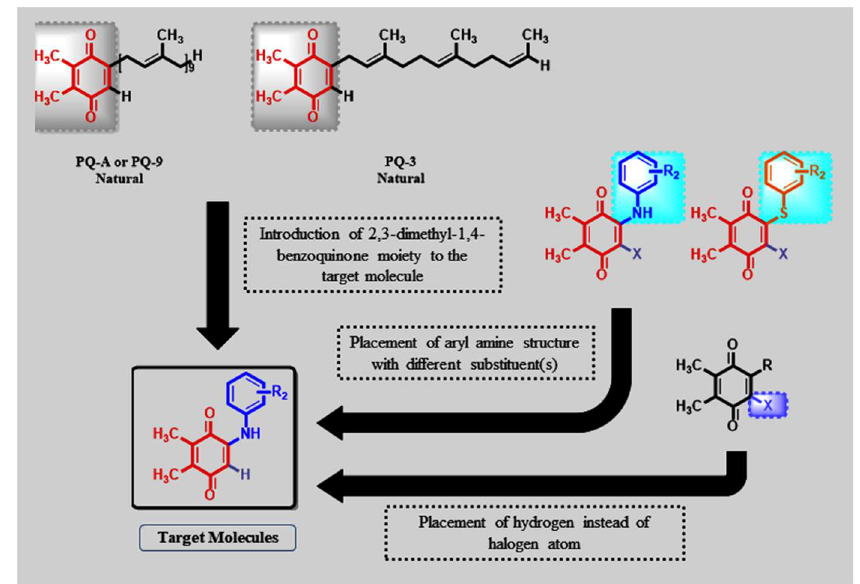
Figure 3. Design concept of PQ analogs based on our previous studies.